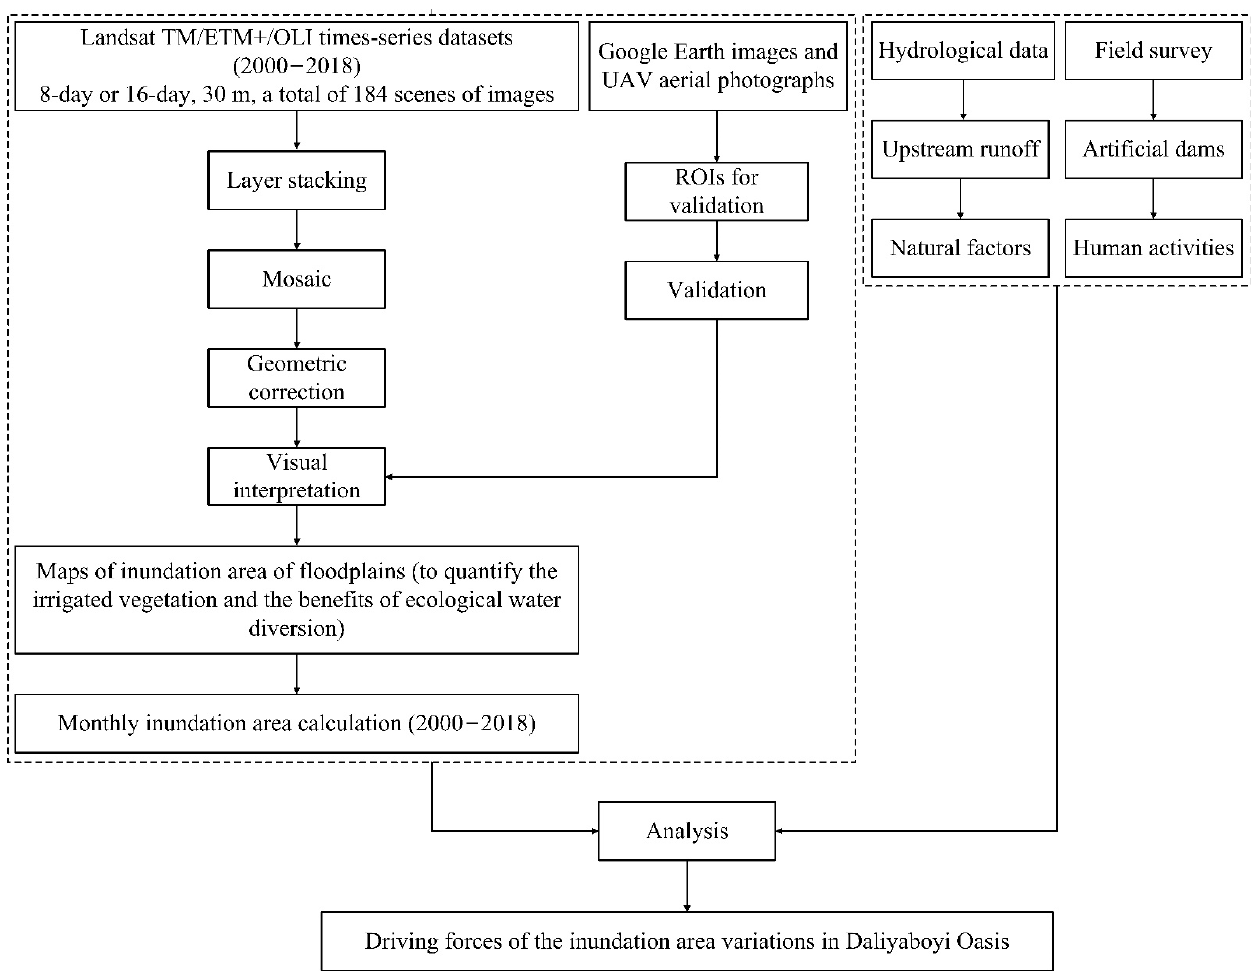
Figure 4. Schematic workflow of Landsat image processing, inundation area mapping and valida- tion, and driving factor analysis. and driving factor